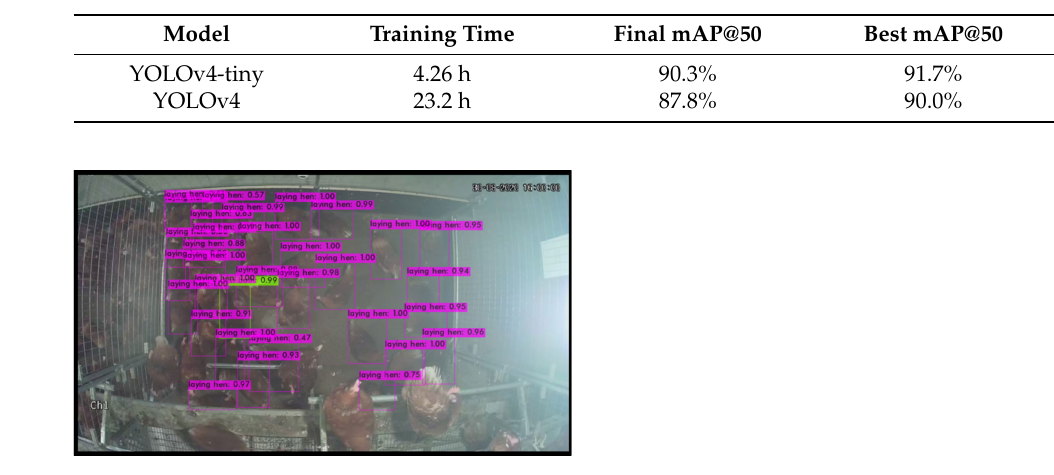
boxes identify images as dust-bathing hens with the corresponding confidence interval.